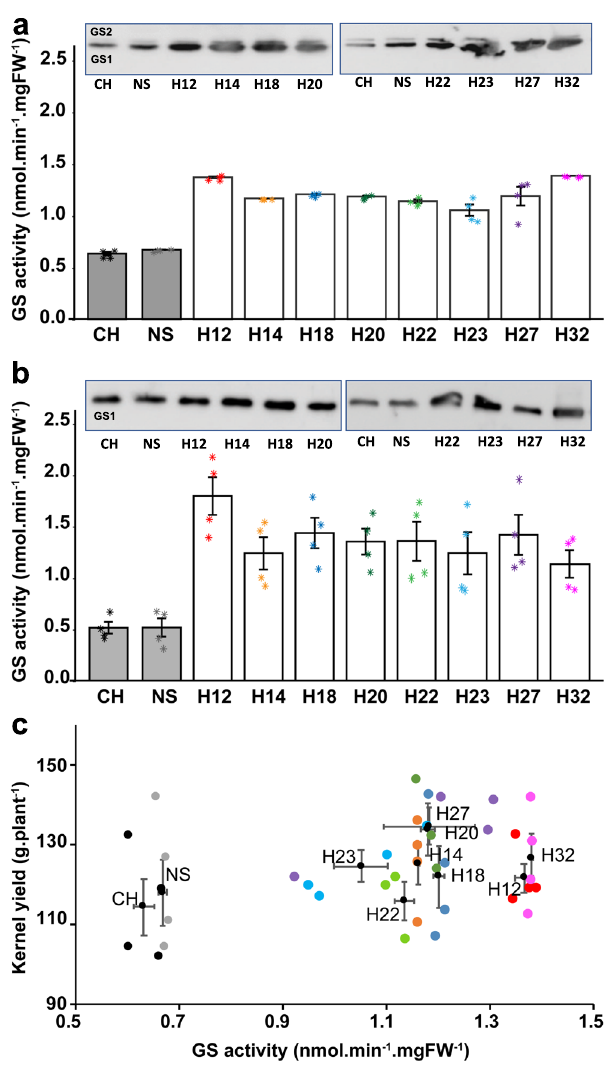
Fig. 1 Characterization of the maize hybrids overexpressing Gln1-3 . The transgenic and control hybrids were grown in the fi eld in 2011 in Finch (MA, USA). a Glutamine synthetase activity in leaves of untransformed control hybrids (CH), a pool of two bulks of hybrids null segregants (NS), and eight independent transgenic hybrids overexpressing Gln1-3 under the control of the CsVMV and the maize RbcS promoters (H12 to H32) at the vegetative (V) stage. b Total leaf GS activity and subunit composition at the grain fi lling stage, 15 days after silking (15DAS). Total leaf GS activity was measured on four different plants for each of the eight independent transgenic hybrids and protein gel blot analysis was conducted using proteins extracted from a pool of the four different plants for each transgenic hybrid and controls. In panels a , b a protein gel blot showing the GS subunit composition in the leaves of the untransformed hybrids and null segregants and the eight hybrids overexpressing Gln1-3 is shown. At the V stage, the upper band (molecular mass of 44 kDa) corresponds to the plastidic GS (GS2) subunit, and the lower band (molecular mass of 40 kDa) corresponds to the cytosolic GS (GS1) subunit for the vegetative (V) stage. At 15DAS only GS1 subunit was detected. The two separate sets of protein gel blots shown in both ( a , b ) were selected from the original gel blots presented in Supplementary Fig. 2. c Scatter plot showing the relationship between kernel mass per plant and total leaf GS activity at the V stage in untransformed control plants and the eight independent hybrids overexpressing Gln1-3 . Kernel mass per plant (g) was measured on four plants for each transgenic hybrid grown in the fi eld in 2011 (location Finch, MA, USA) under non-limiting N fertilization conditions. Values are the mean ± SD for GS activity and yield. For the eight transgenic hybrids, the yield increase was on average 7% higher compared to the CH and the NS ( P = 0.04). Symbols asterisks ( a , b ) and dots ( c ) for the values of the four plants: CH: black, NS: gray, H12: red, H14: orange, H18: blue, H20: dark green, H22: light green, H23: light blue, H27: purple, H32: